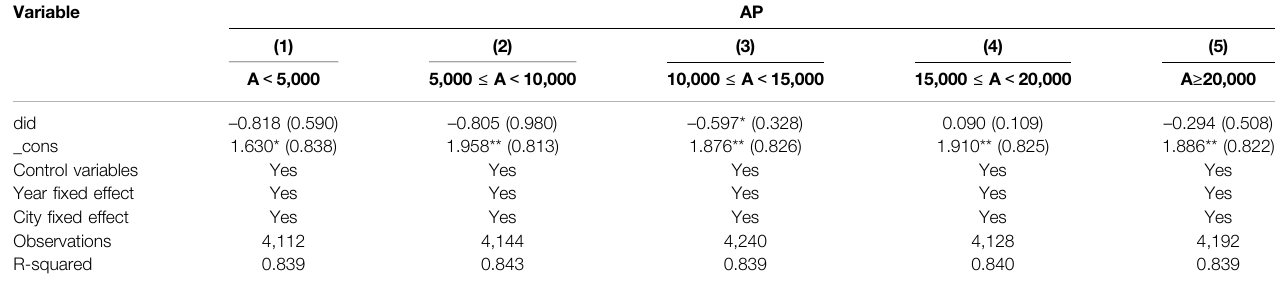
TABLE 5 | Selection of pilot cities based on administrative areas.